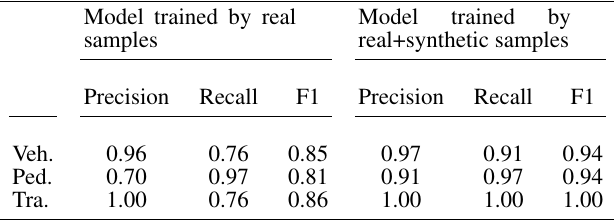
Table 3. Comparison of classification results for models trained with and without synthetic